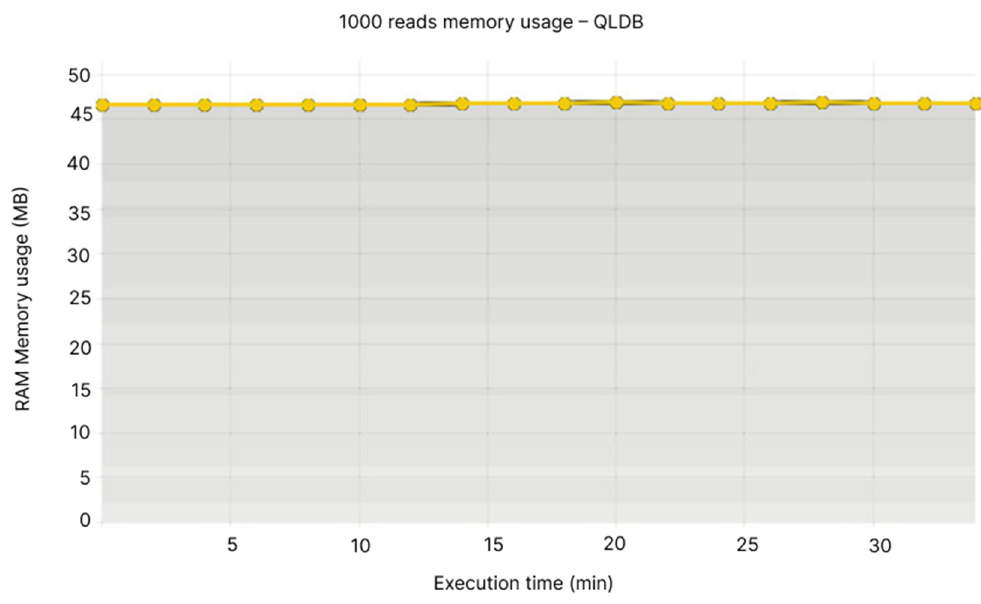
Figure 21. 1000 reads memory usage—QLDB.